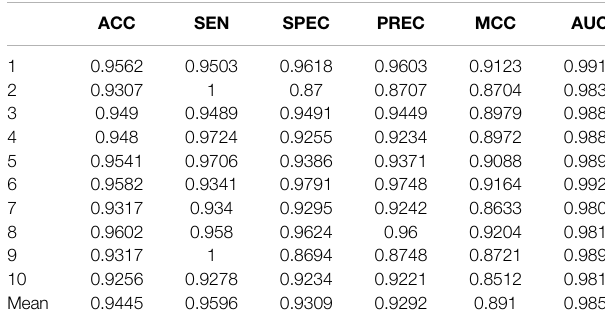
TABLE 1 | Results of 10-fold cross-validation.